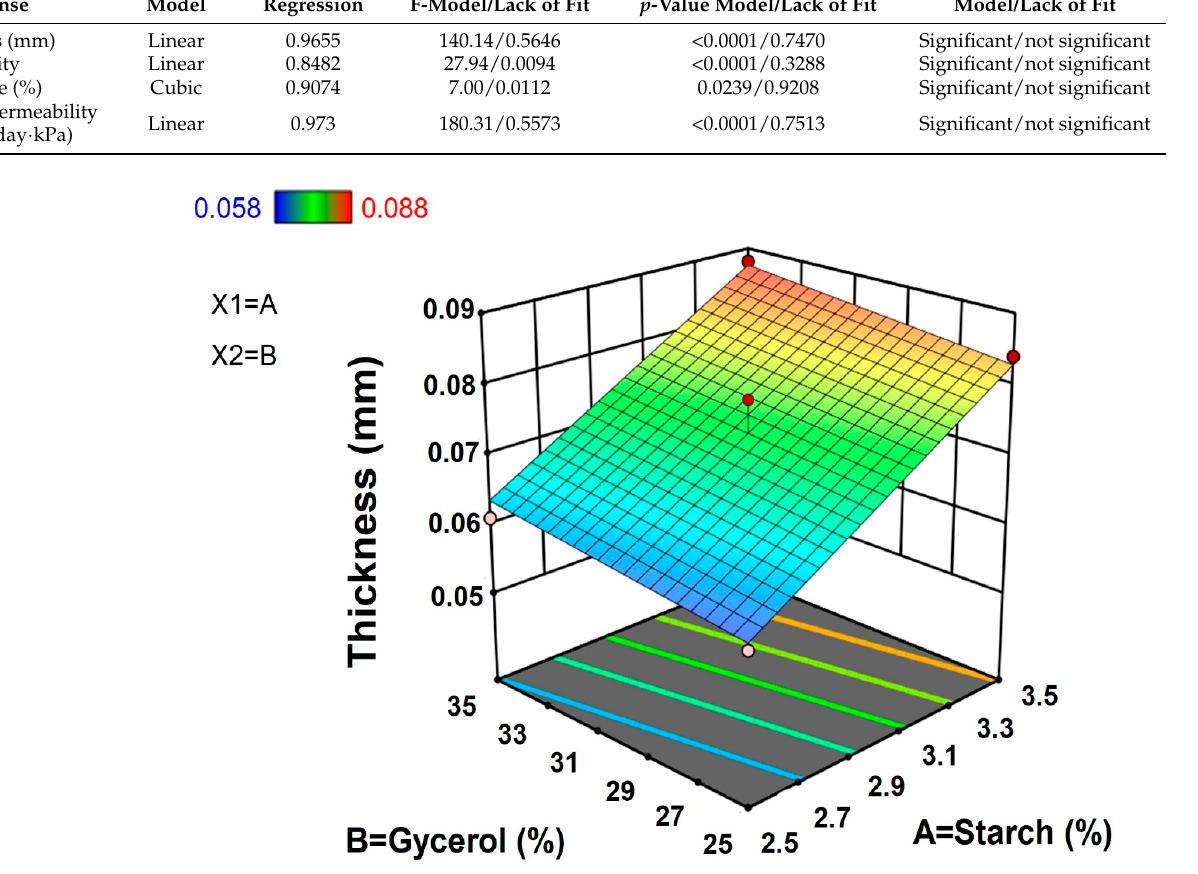
Figure 2. Response surface plot for thickness of taro peel starch biodegradable films. Table 2. Analysis of variance using ANOVA.